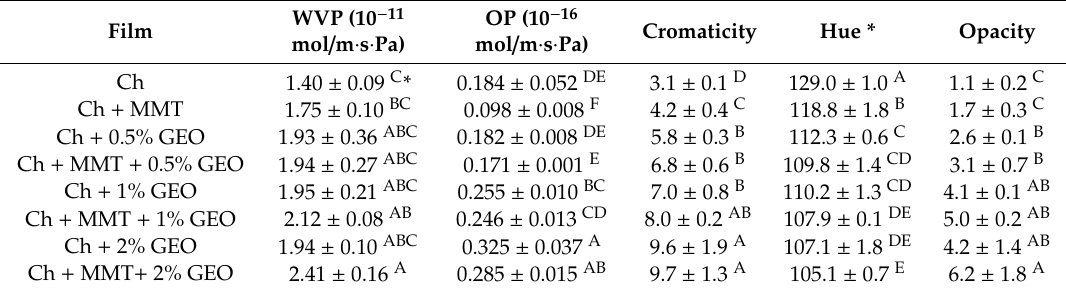
(A–E): values in the same column not sharing upper case superscript letters indicate statistically